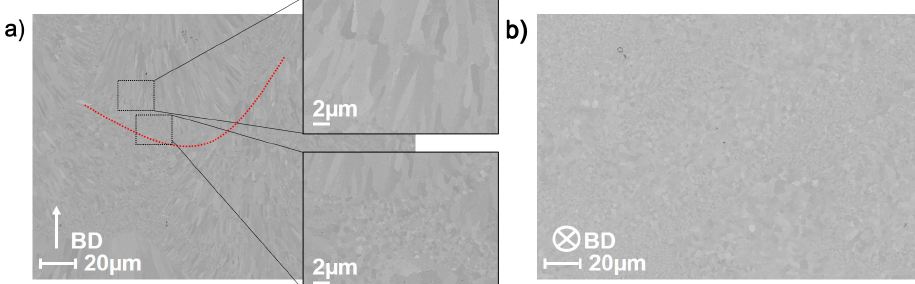
Figure 8. Electron microscopy images showing ( a ) XZ section and ( b ) XY section of as-printed sample in back-scattered mode. Notice the inset images in ( a ), which show clear grain refinement at melt pool